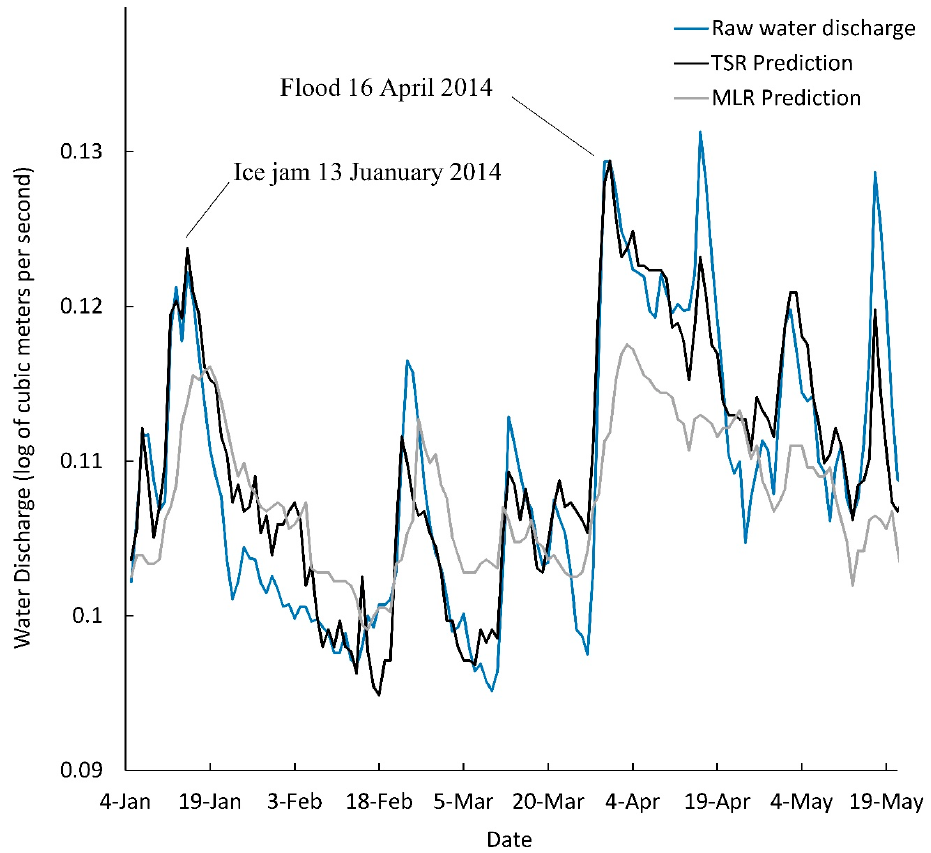
Figure 9. The raw water discharge data (blue line), the water discharge data derived from the TSR model (black line), and the water discharge data derived from the multiple linear regression (MLR) model (grey line). The water discharge data is the logarithmic transformation of the cubic meters per second values measured from 4 January 2014 to 19 May 2014.